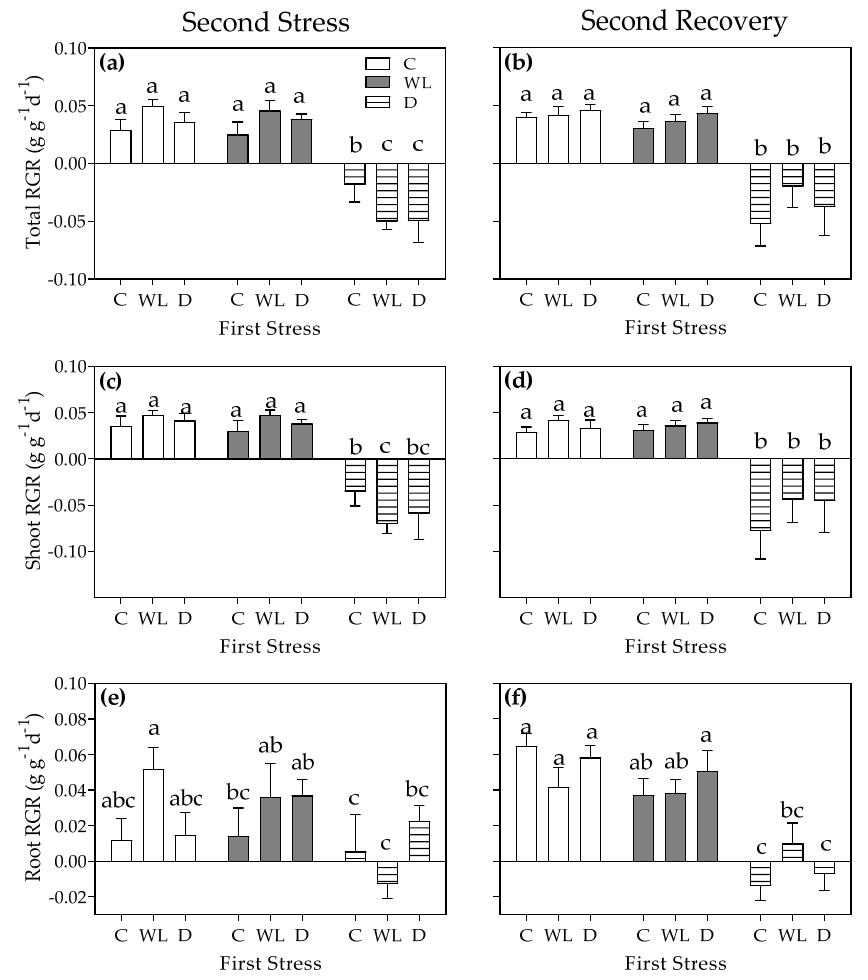
Figure 3. Total ( a , b ), shoot ( c , d ), and root ( e , f ) relative growth rates (RGR) of Chloris gayana plants subjected for 8 days to control conditions (C, white bars), waterlogging (WL, grey bars), or drought (D, striped bars) in the second stress round ( a , c , e ) and their subsequent 15-day recovery phase ( b , d , f ). Values are means ± e.e. (n = 8). Different letters indicate differences between treatments ( p < 0.05).